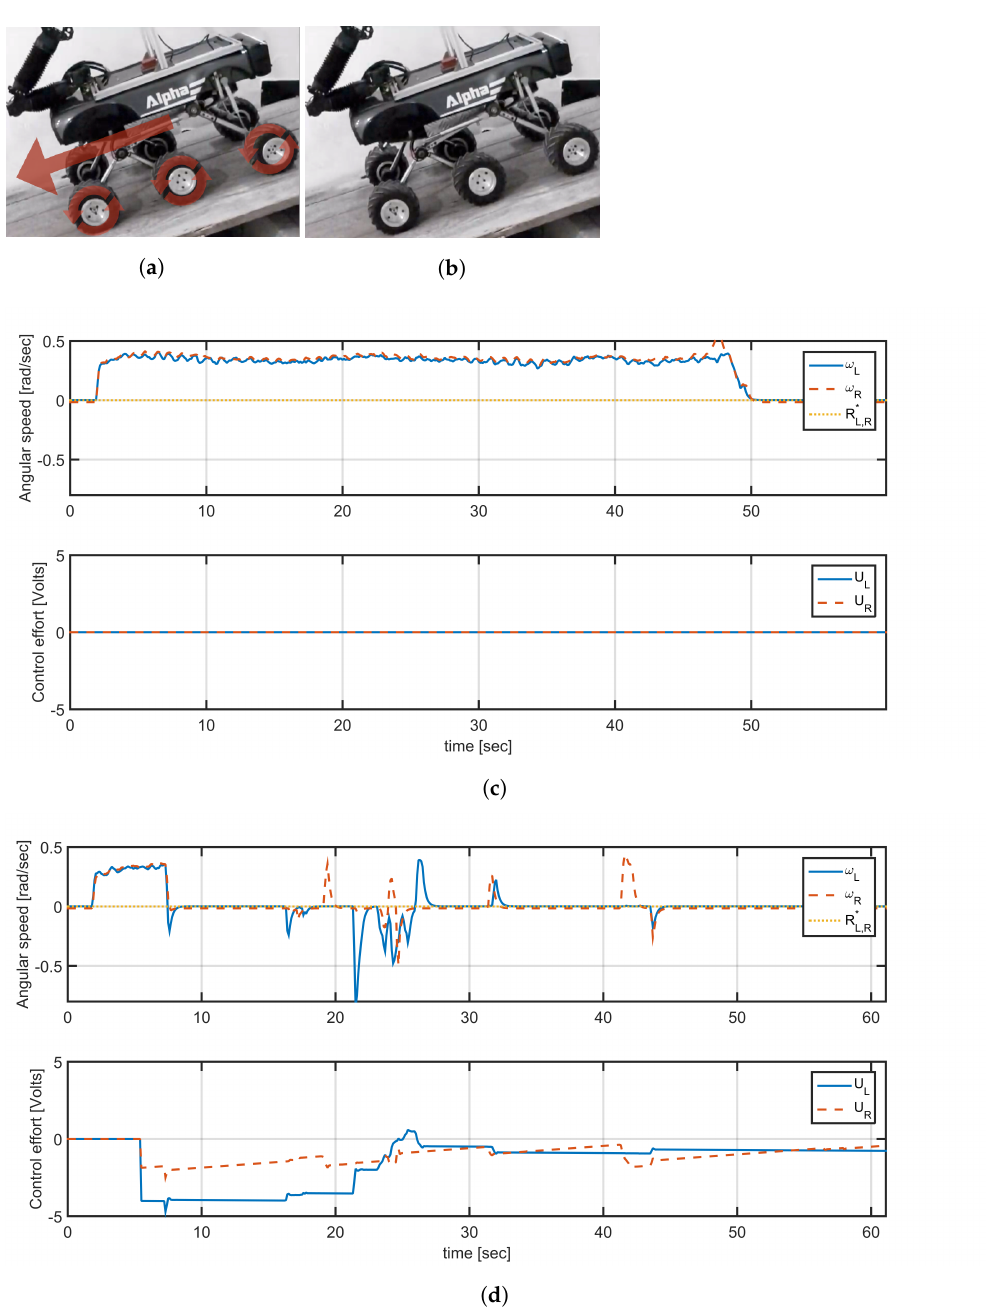
Figure 10. Speed control response in rad/s to a 30 ◦ incline: ( a ) the robot rolls on the ramp, ( b ) angular speed responses without control, ( c ) the robot holds its position without rolling effect, and ( d ) angular speed responses with. Left motors speed (blue), sped of one of the right motors speed (red), angular speed reference (yellow).The horizontal axis is in samples, with a sample time T s = 0.1